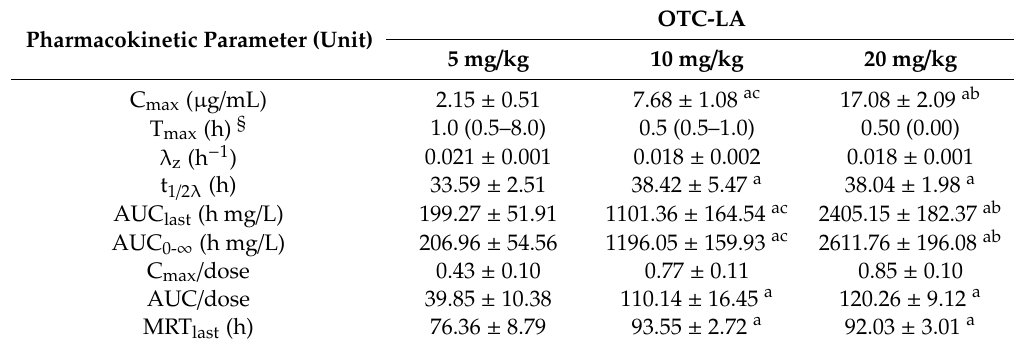
Table 1. Mean ± SD values of the pharmacokinetic parameters of the long-acting formulation of oxytetracycline (OTC-LA) following intramuscular administration at three different dosages (5, 10 and 20 mg/kg body weight (b.w.)) in the freshwater crocodile, Crocodylus siamensis ( n = 5 per group). Pharmacokinetic Parameter (Unit)